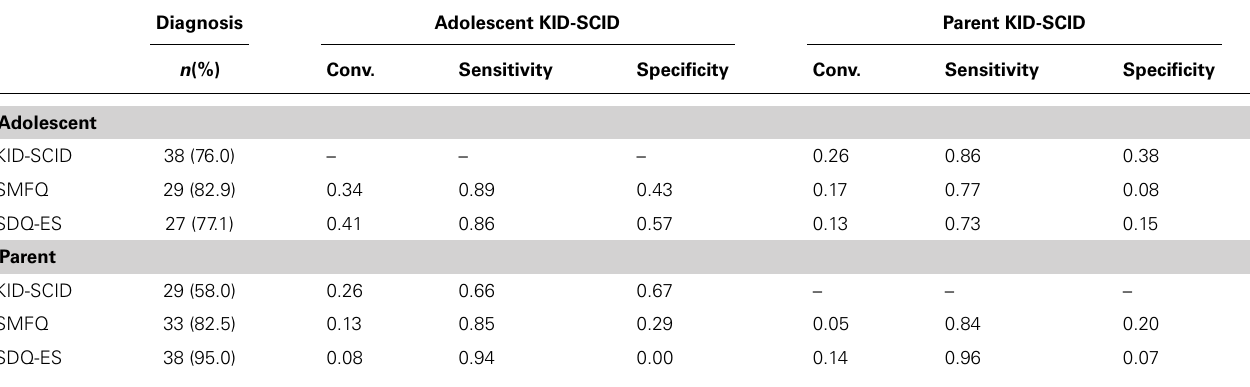
Table 1 | Diagnosis, convergence, sensitivity, and specificity scores using theAdolescent KID-SCID MDE module or the parent KID-SCID MDE module. Diagnosis